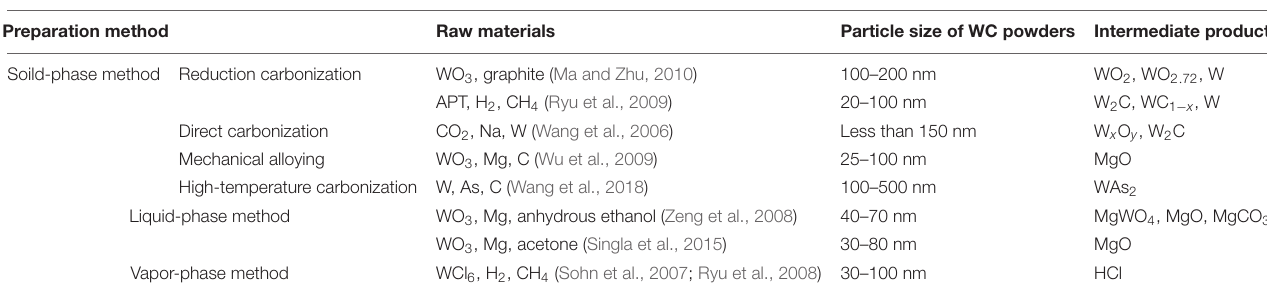
FIGURE 14 | TEM micrographs of (A) WC 1 - x powder synthesized by plasma-assisted CVS from WCl 6 and (B) WC powders obtained after 5 h of hydrogen heat treatment of WC 1 - x powders at 900 ◦ C (Sohn et al., 2007) [Figure 1 of Sohn et al. (2007), Copyright Elsevier Ltd]. TABLE 1 | Comparison of characteristics of WC prepared by different